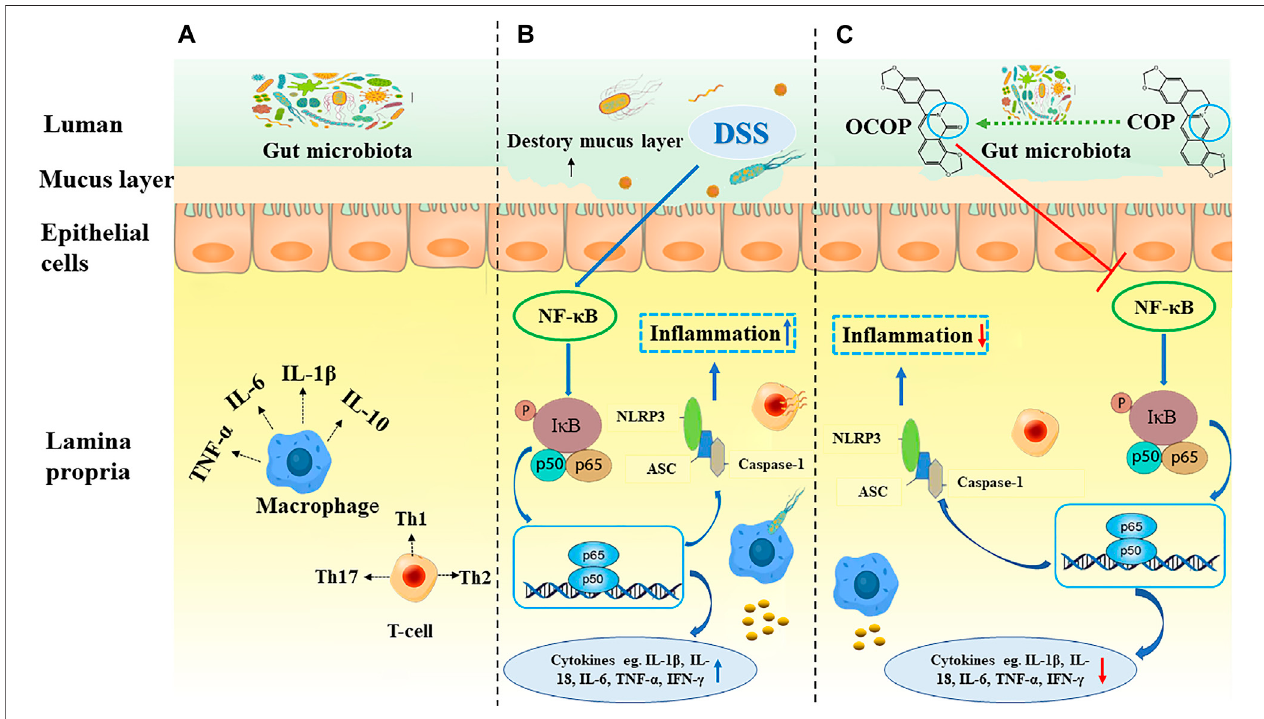
FIGURE 11 | Summary scheme of the mechanisms underlying the inhibitory effect of OCOP (A) Normal intestinal tract (B) DSS-induced colitis (C) OCOP- pretreatedcolitis.OCOP,anovelgutmicro fl orametaboliteofCOP,signi fi cantlyblockedNF- κ BpathwayandNLRP3in fl ammasomethroughdown-regulatingtheprotein expression of ASC, NLRP3 and Caspase-1, suppressing the phosphorylation of I κ B α and the migration of NF- κ B p65 from cytoplasm to nucleus.